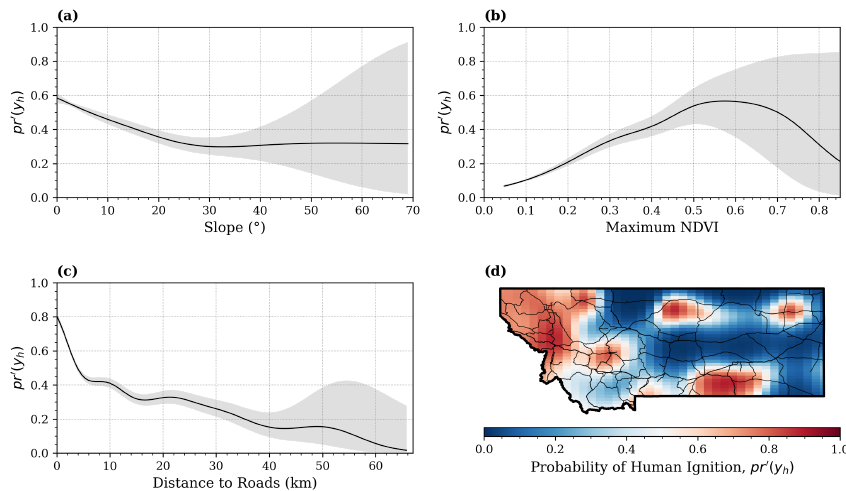
Figure 8. Partial effects plots for slope ( a ), maximum NDVI ( b ), distance to roads ( c ) and longitude and latitude ( d ) included in the spatial-GAM built to predict the probability of a human-caused wildfire ignition, pr ( y h ) .